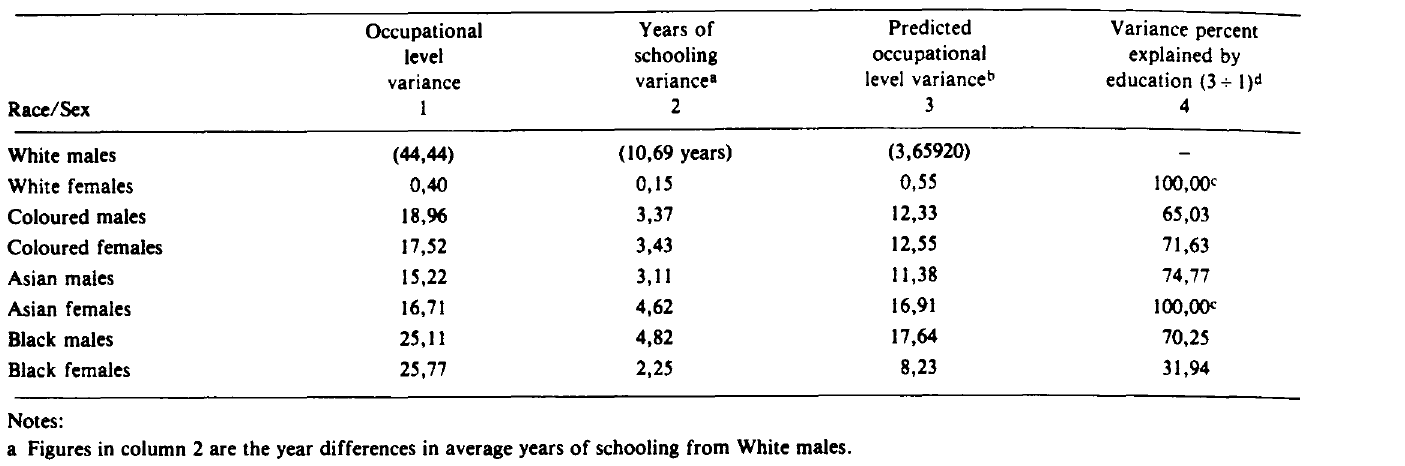
Table 2 Percent labour market discrimination explained by all levels of education for race/sex